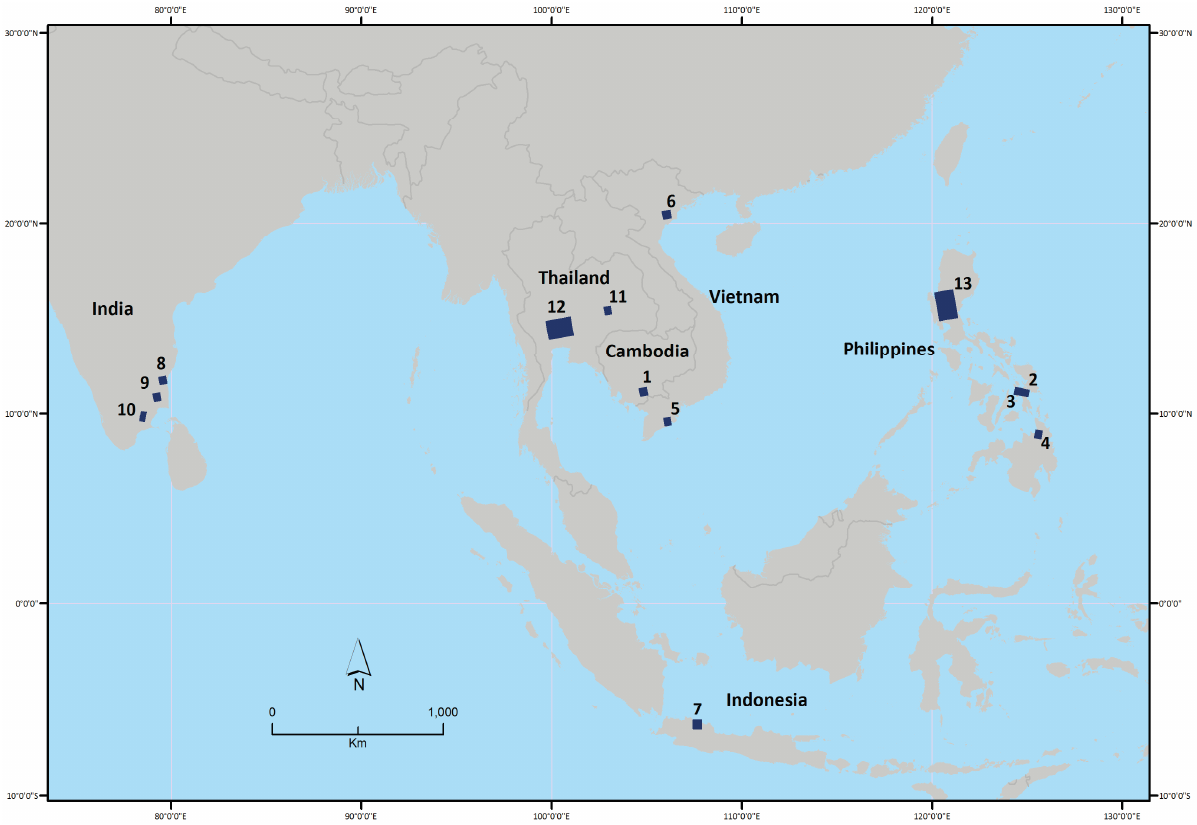
Figure 2. Location of the 13 SAR footprints in Asia in the RIICE (Remote Sensing-based Information and Insurance for Crops in Emerging economies) project. Country names are shown only where there are footprints. Numbers refer to the site ID used in Table